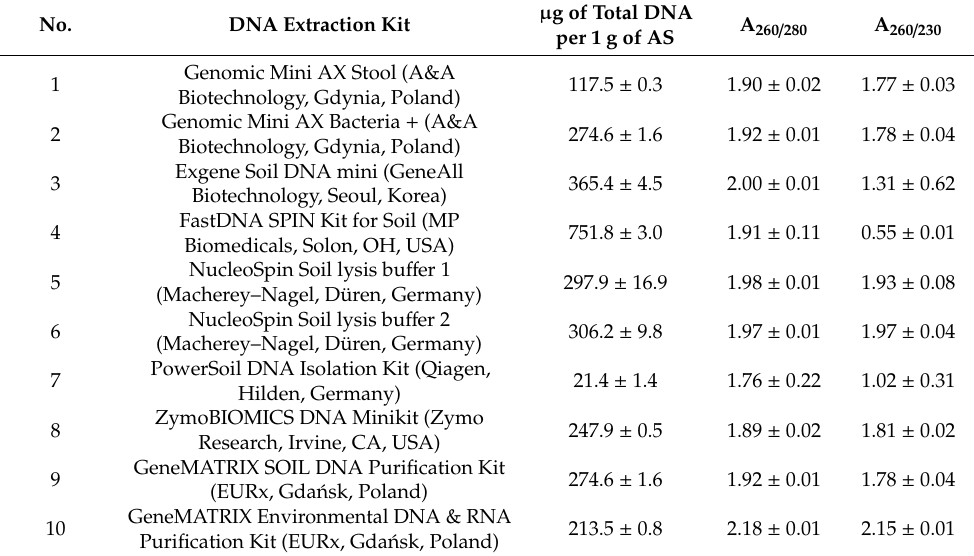
Table 1. Results of quantitative and qualitative analysis of DNA extracted from activated sludge collected in WWTP1 using di ff erent commercially available DNA isolation and purification